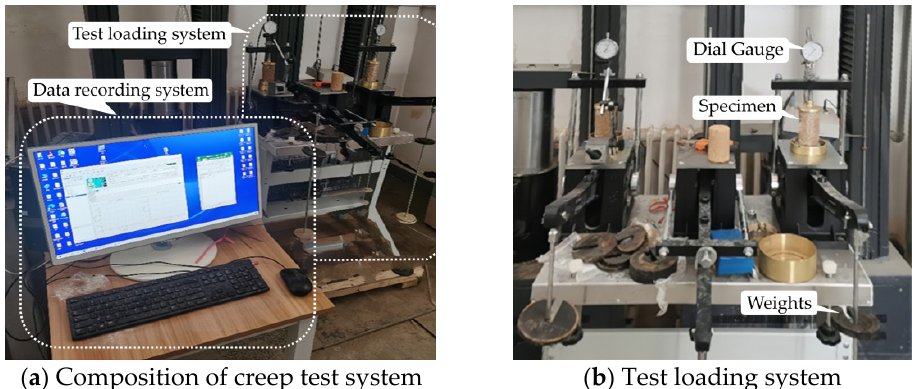
Figure 3. Uniaxial creep characteristic test system: ( a ) composition of the creep test system and ( b ) the test loading system. the test loading